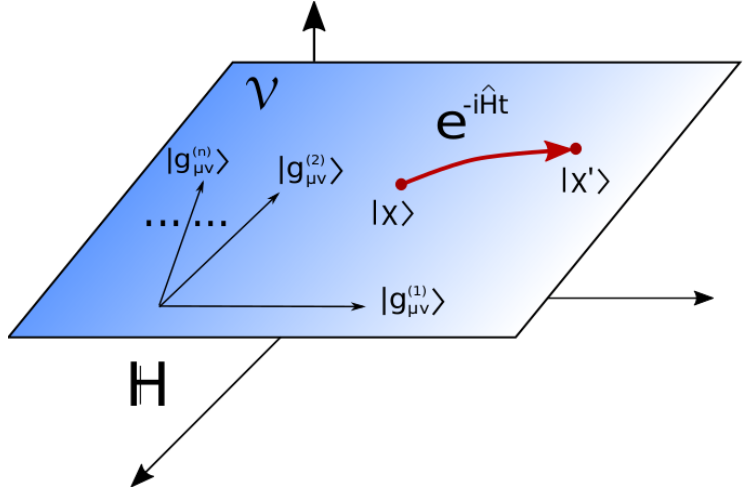
Figure 1 . In the full Hilbert space H of matter (cid:12)elds, a sub-Hilbert space V is spanned by a set of basis vectors, where each basis vector is associated with a spatial metric. A general state in V can be written as a linear superposition of the basis vectors, (cid:31) ( g (cid:22)(cid:23) ) is a wavefunction de(cid:12)ned in the space of spatial metric. An endomorphic Hamiltonian ^ H generates a map from V into V . Therefore, (cid:12) (cid:12) (cid:11) R Dg (cid:31) 0 ( g (cid:22)(cid:23) ). The linear map between (cid:31) ( g (cid:22)(cid:23) ) and (cid:31) 0 ( g (cid:22)(cid:23) ) can be written as (cid:31) 0 ( g (cid:22)(cid:23) ) = (cid:12) g (cid:22)(cid:23) (cid:22)(cid:23) h (cid:16) (cid:17)i exp (cid:0) i t H g (cid:22)(cid:23) ; @ (cid:31) ( g (cid:22)(cid:23) ), where H @g (cid:22)(cid:23) the metric.